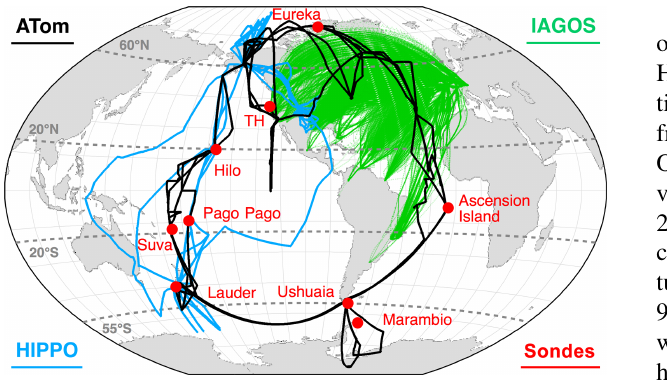
Figure 1. The location and flight tracks of all O 3 monitoring plat- forms used in this work are illustrated using different markers and colors. The ATom flight track is in black, the HIPPO flight track is in blue, IAGOS flight paths are in green, and the ozonesonde launching sites are indicated by the red markers. The dotted gray lines define the latitudinal bands over which individual ATom and HIPPO profiles were averaged to derive a regional O 3 distribution: the tropics (20 ◦ S–20 ◦ N), the midlatitudes (55–20 ◦ S, 20–60 ◦ N), and the high latitudes (90–55 ◦ S, 60–90 ◦ N). Only data from remote oceanic flight segments of ATom and HIPPO missions were used in this